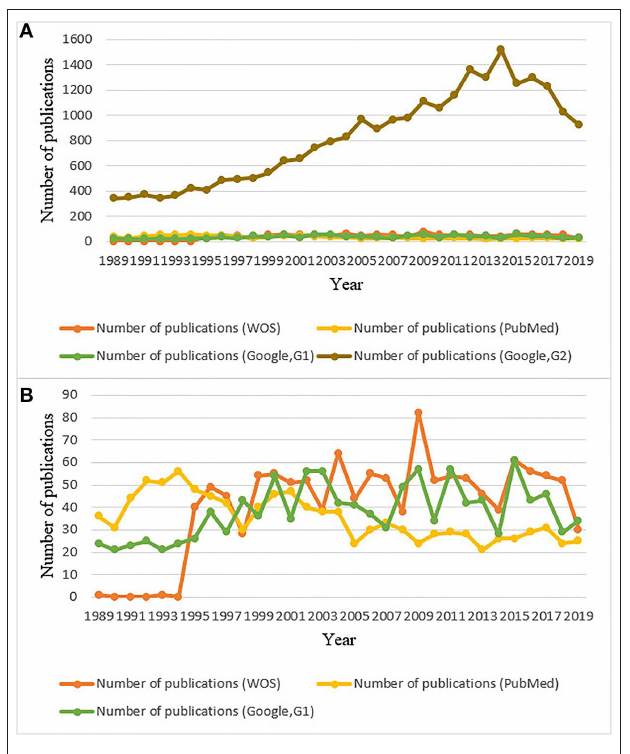
FIGURE 1 | Number of publications of each year from 1989 to 2019 based on WOS, PubMed, and Google Scholar. G1: Publications in Google that include “horseshoe crab” only in titles. G2: Publications in Google that include “horseshoe crab” in whole articles. The number of publications from WOS, PubMed, G1, and G2 are all included in (A) , the number of publications excluded G2 are listed in (B) .